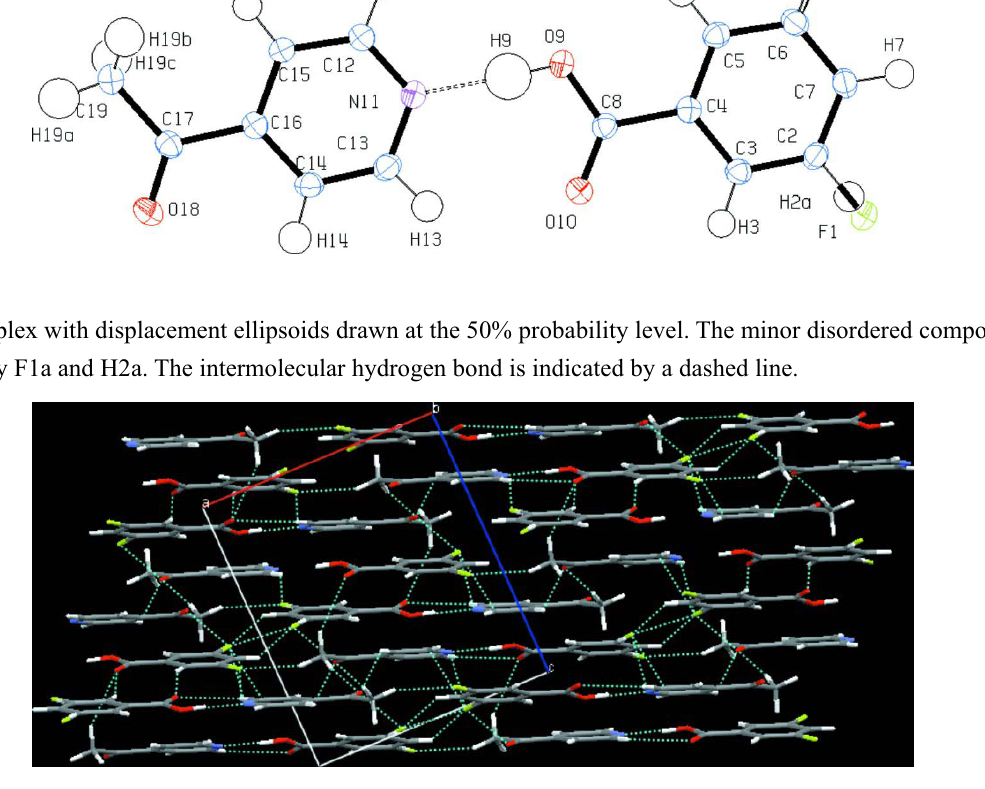
Packing figure viewed along the b axis. The tilted layer structure can be clearly seen and close intermolecular C—H···F and C—H···O distances are represented by dotted